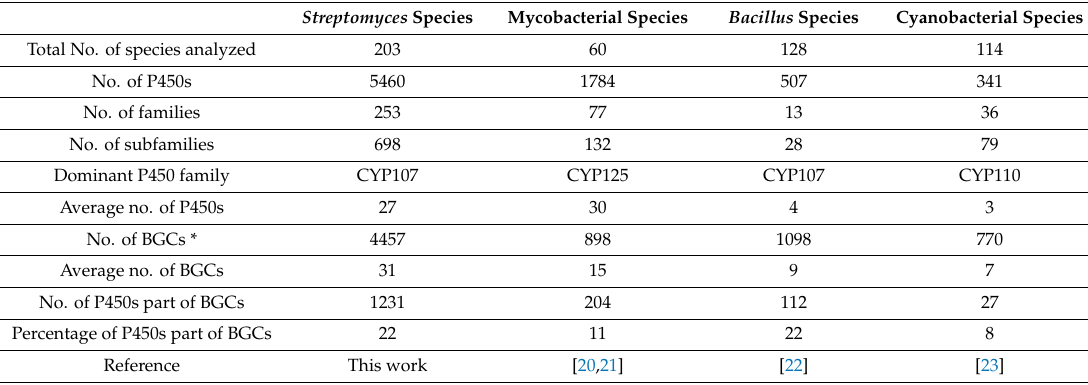
Table 2. Comparative analysis of key features of P450s in di ff erent bacterial